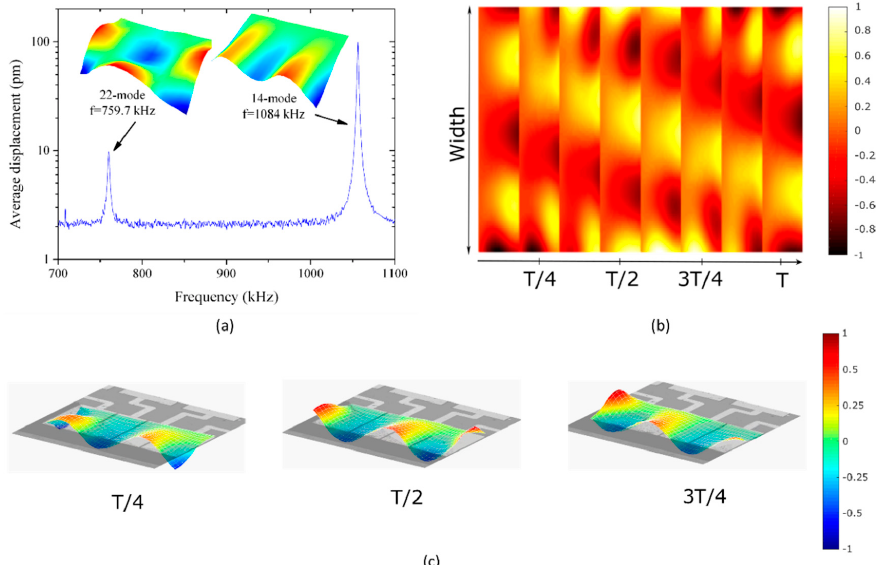
Figure 5. ( a ) Measured frequency response of the cantilever from 700 kHz to 1.1 MHz. Time frame of the measured TW by combining Modes (22) and (14). ( b ) 2D representation and ( c ) 3D representation (a video clip is available (Video S2)). The colors represent the normalized displacement of the cantilever. T corresponds to the period of the TW.